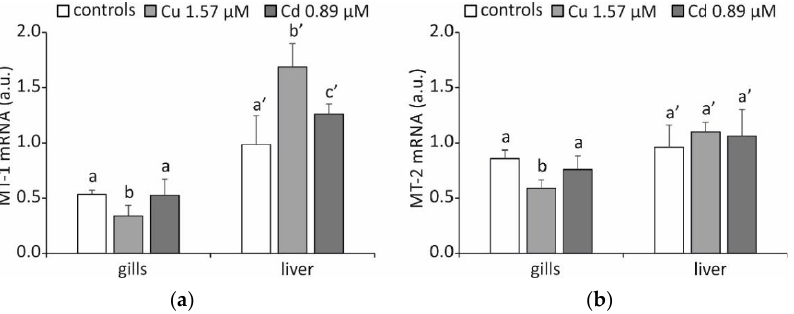
Figure 2. MT mRNA accumulation (arbitrary units) in gills and liver of T. hansoni . The results are expressed as the mean of five specimens ± SD. Different letters with the same index correspond to significant statistical differences among the different experimental conditions for p < 0.05. ( a ) MT-1; ( b ) MT-2.